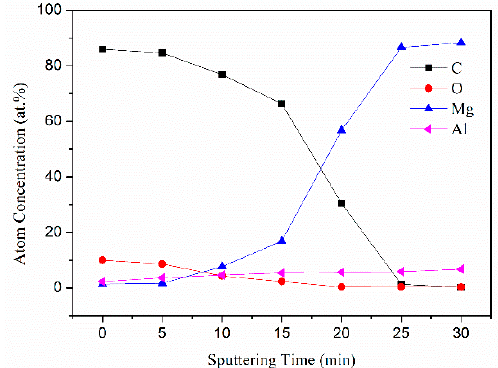
Figure 1. XPS element depth profile of the AM60 alloy after C ion implantation at 6 × 10 6 ions/cm 2 with a sputtering rate of 10 nm/min.